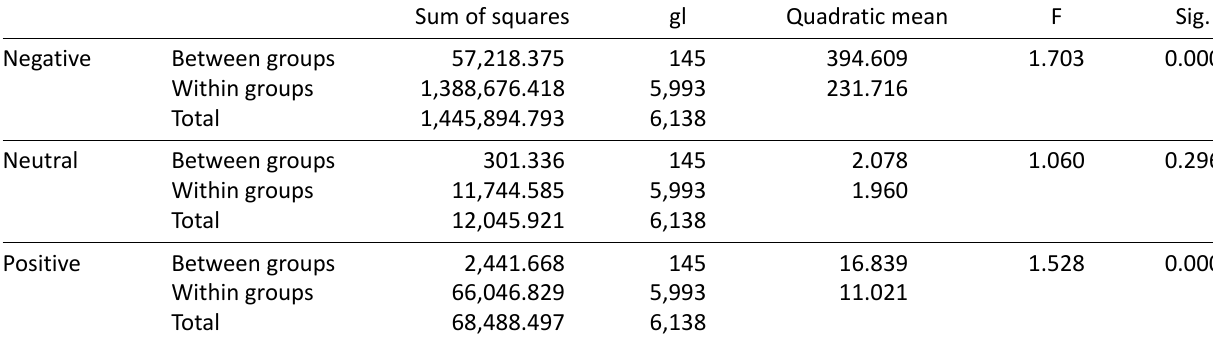
Table 4. Statistics of the analysis of the averages of the variances for RQ2. Sum of squares gl Quadratic mean F Sig.